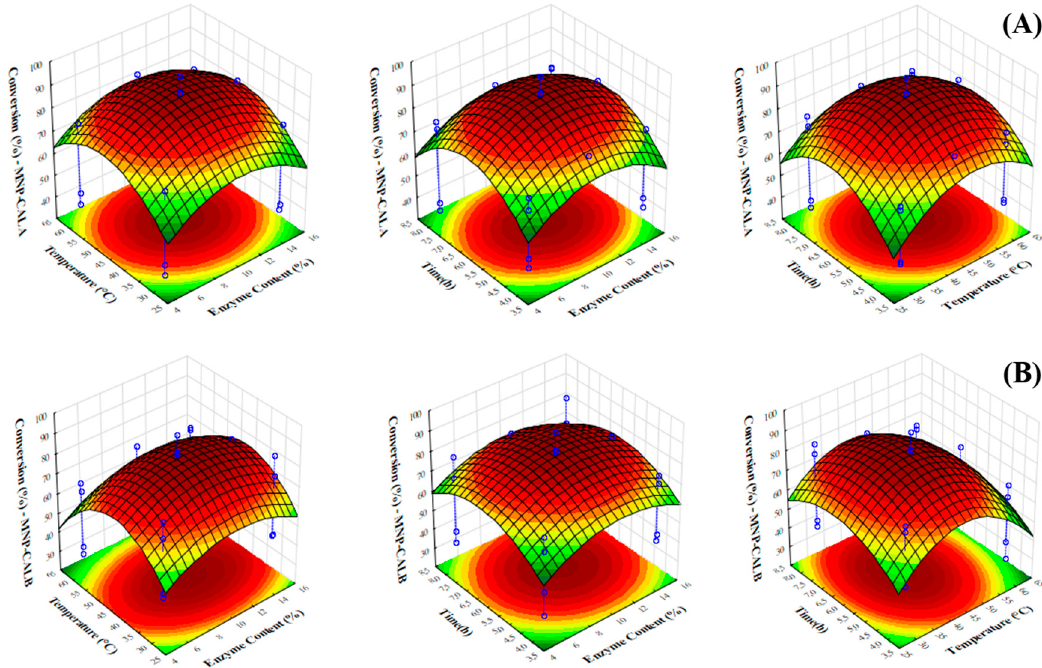
Figure 3. Fitted response surfaces. ( A ) CALA-MNP; ( B ) CALB-MNP. Reaction medium: CALA-MNP or CALB-MNP (5–15 mg), butyric acid (1.0 mol/L), ethyl alcohol 1:1–1:5 (butyric acid/ethyl alcohol), and heptane (reaction volume = 1.0 mL). The reactions were performed for 4–8 h at 30–60 °C and 150× rpm . Further details are given in Section 3.